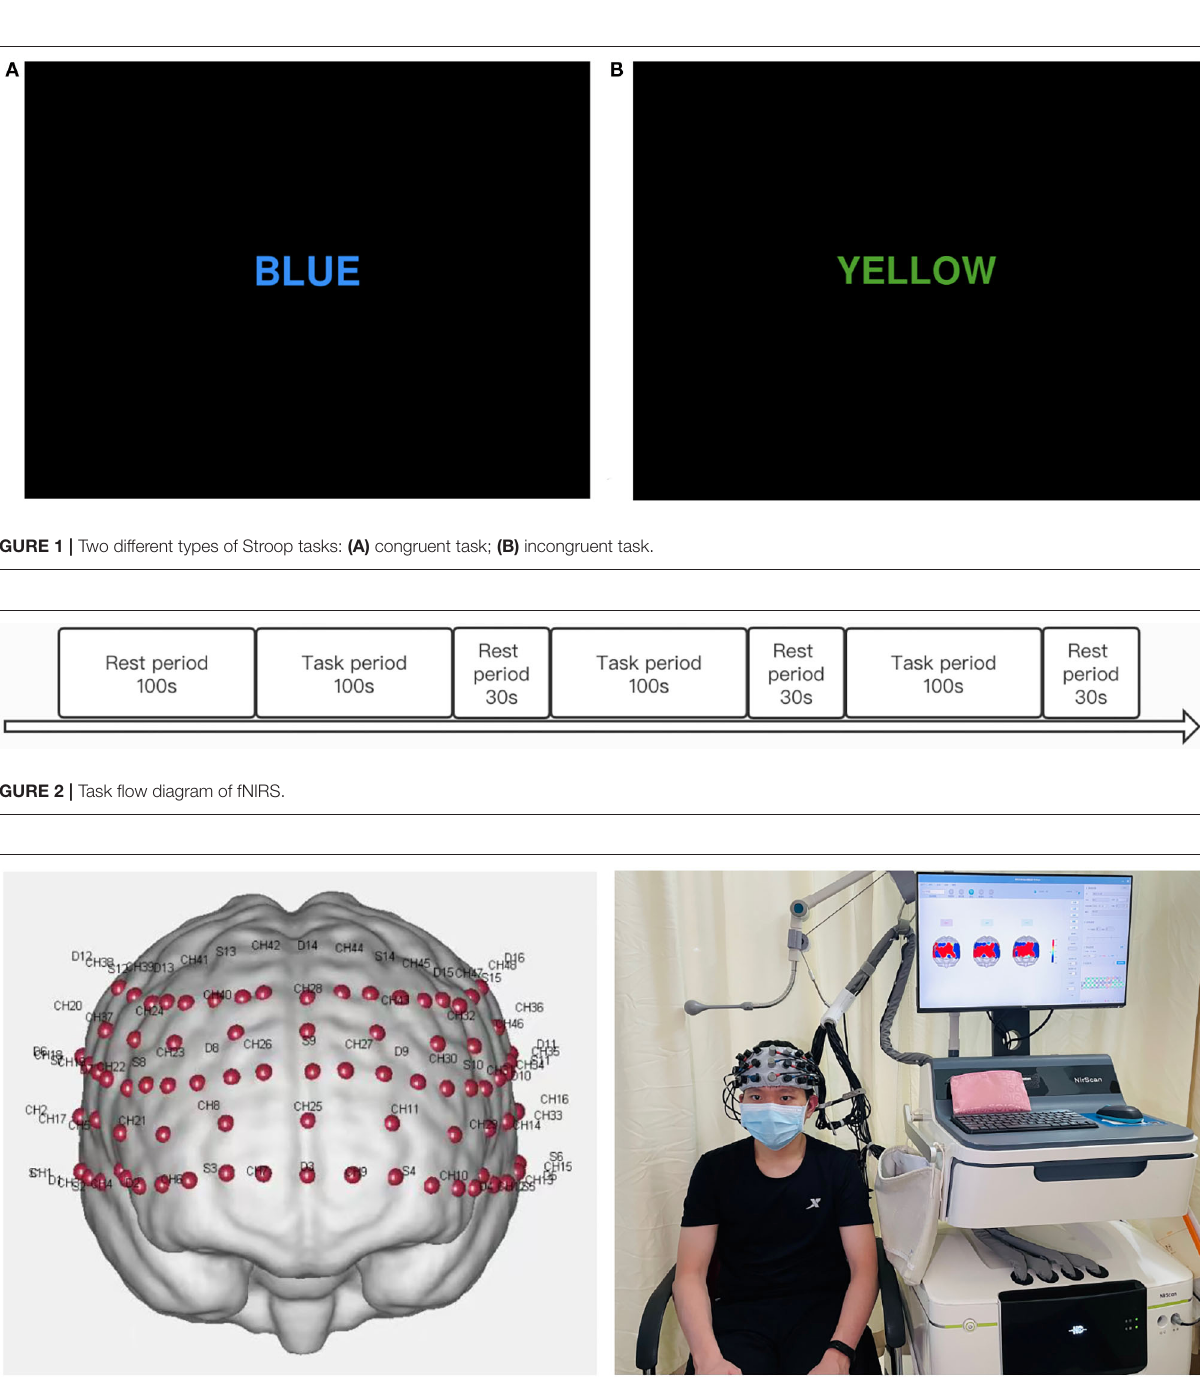
FIGURE 3 | Distribution of channels in the frontotemporal lobe of the brain.